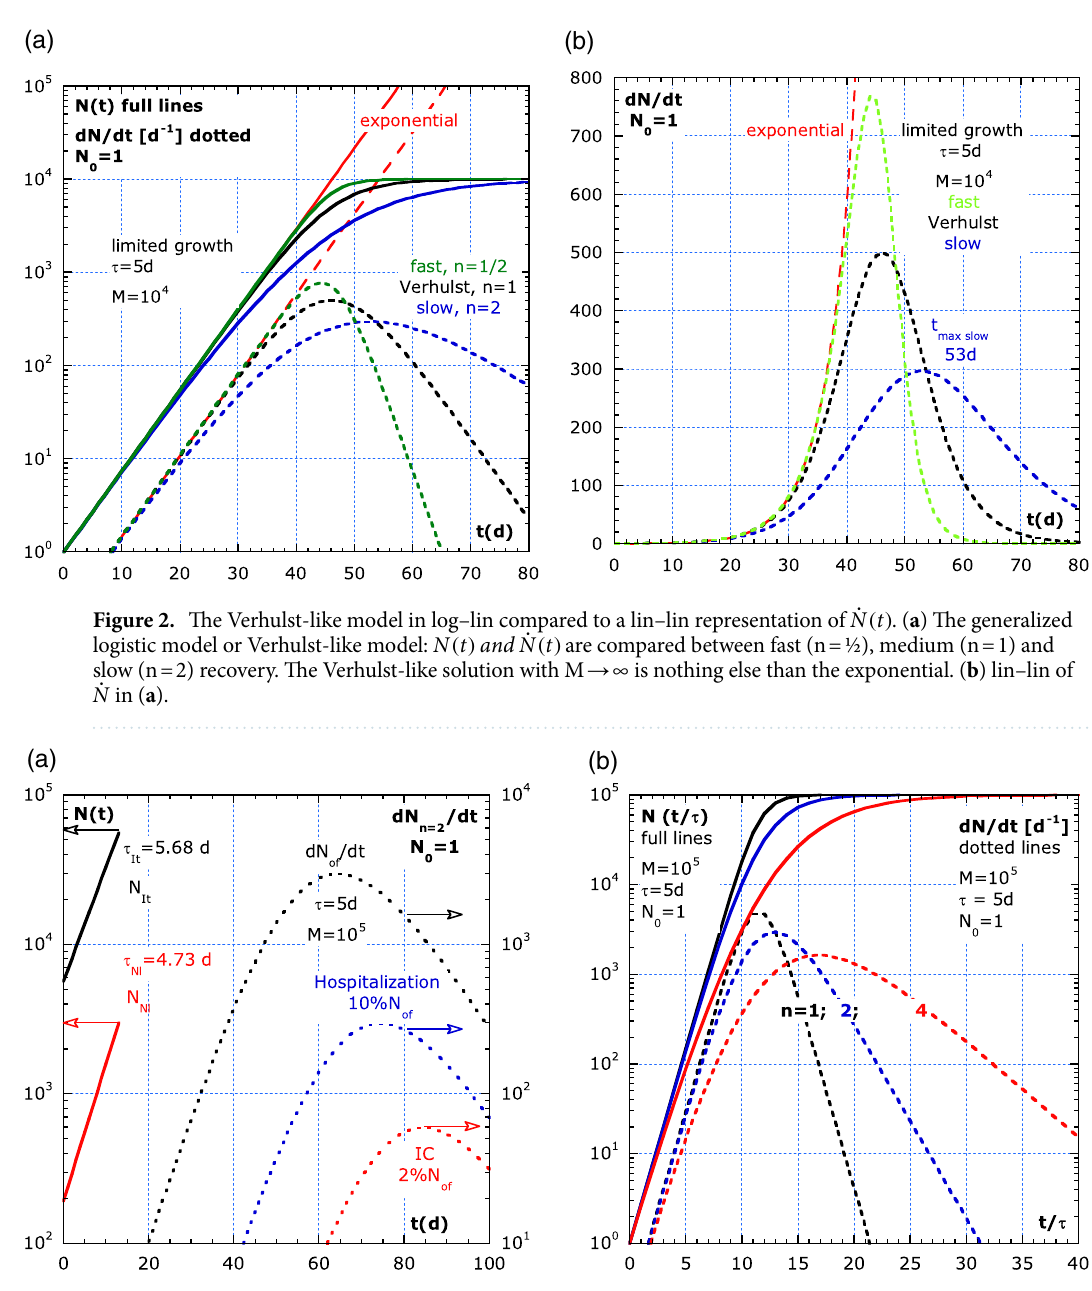
Figure 3. Merits of log–lin plots. ( a ) Real data (full lines) for the number of infections by COVID-19 pandemics in Italy (black) and The Netherlands (red) over only 13 days, t = 0 corresponds to 7 March 2020. The inferred τ Nl = 4.7 d and τ It = 5.7 d from the log–lin plot suggest a different handling by authorities. ( b ) The merits of a log–lin plot by the simulation of N (full lines) and ˙ N (dotted